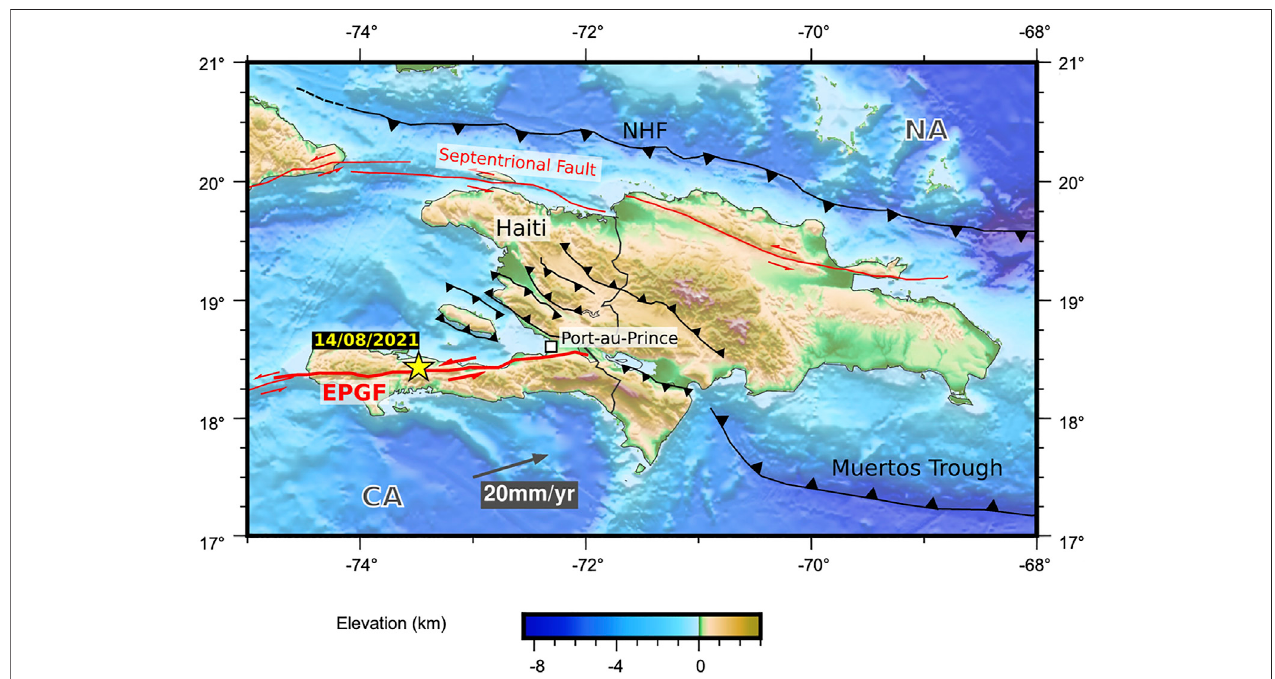
FIGURE 3 | Regional Tectonics – faults from Saint-Fleur, Feuillet and Klinger (2019) and Symithe et al. (2015). The tectonics of Hispaniola, of which Haiti forms the westernpart, isgovernedbytheobliqueconvergenceoftheCaribbean plate (CA) withtheNorth Americanplate(NA) at~20 mm/yr(DeMetsetal.,2010),whichleadsto both compressional motion on thrust faults (black lines, triangles are on hanging wall side) and left-lateral strike-slip faulting (red lines). EPGF is the Enriquillo-Plaintain- Garden Fault, the major strike-slip fault in southern Haiti. NHF is the Northern Hispaniola Fault. The yellow star shows the epicentre of the 14th August 2021